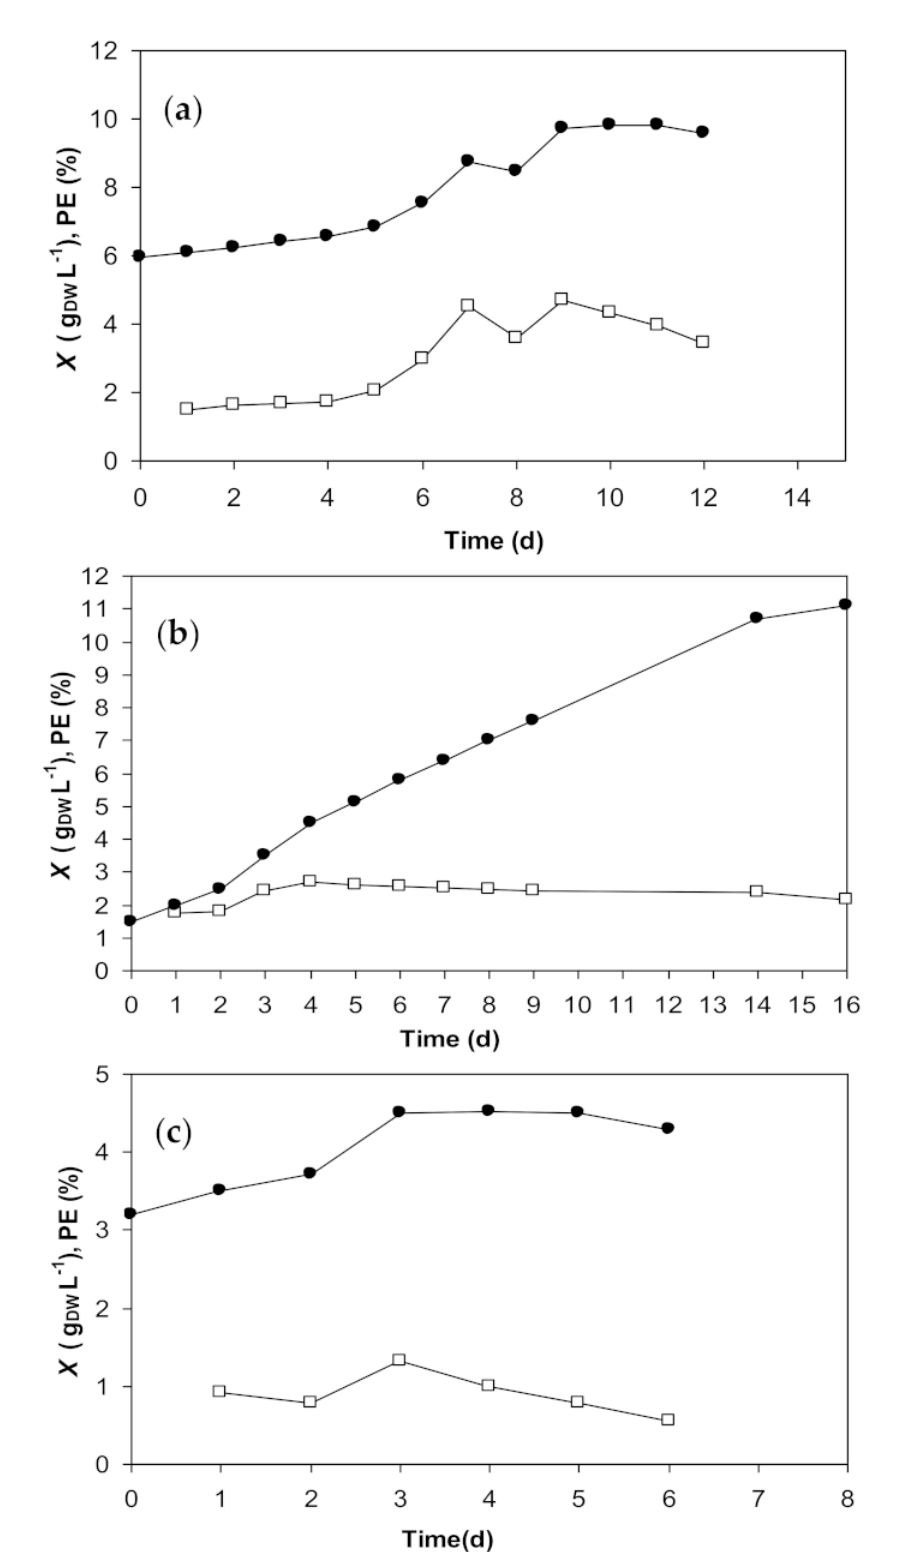
Figure 3. Time behaviors of biomass concentration ( X , • ) and photosynthetic efficiency (PE, (cid:3) ) along fed-batch pulse-feeding cultivation of Arthrospira platensis in a helical photobioreactor at PPFD